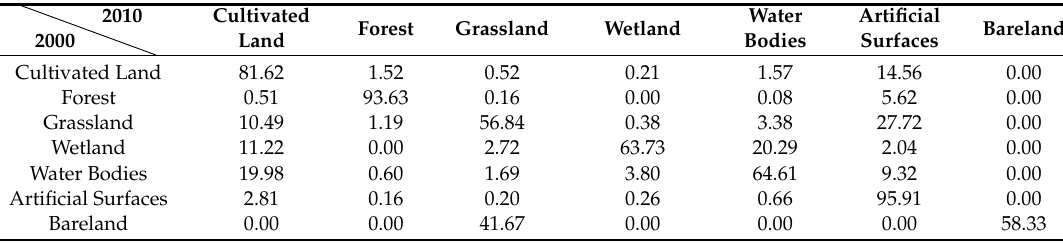
Figure 5. Spatial distribution of urban areas and urbanization rate in the BTH region: ( a ) and ( b ) are urbanization areas in 2001 and 2011, and ( c ) is the urbanization rate from 2001 to 2011. Table 1. Land cover transfer matrix (unit: %).